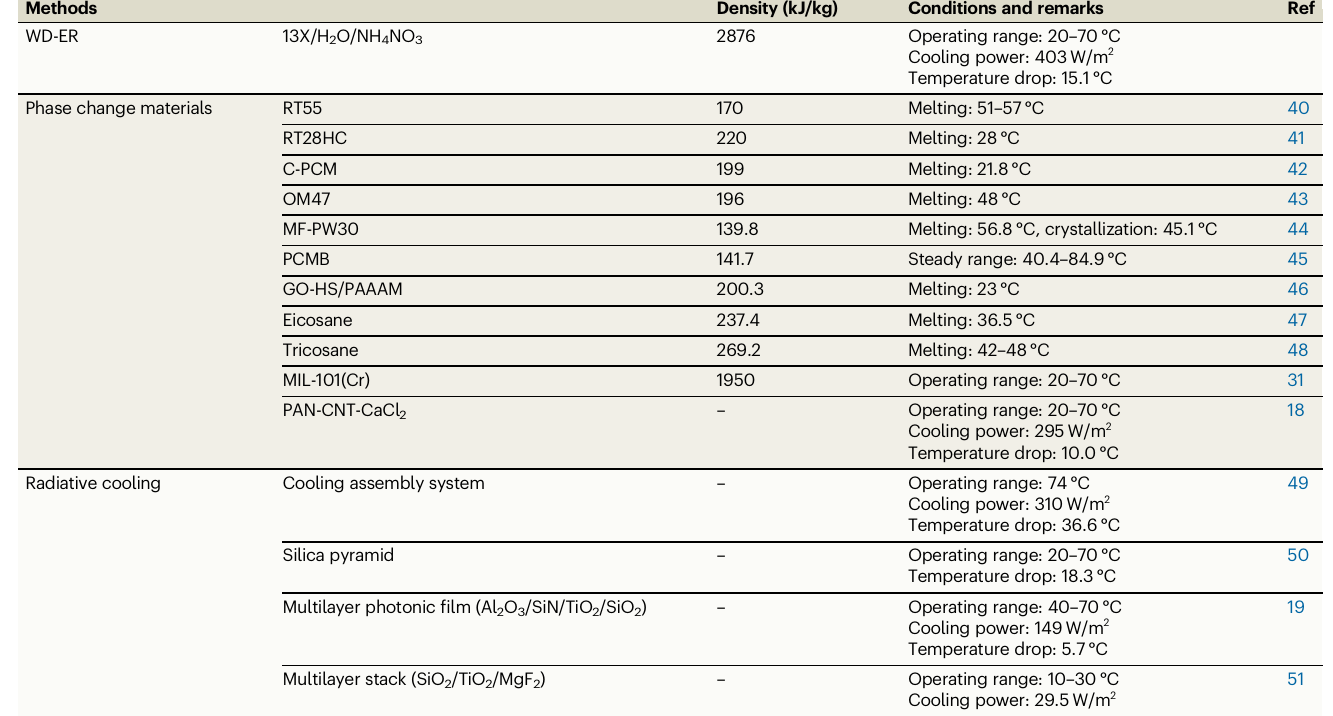
Table 1 | Comparison of WD-ER cooling unit with passive cooling methods Methods Density